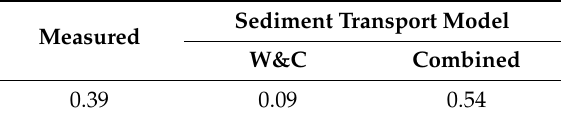
Table 3. The V Sh / V tot values, where V Sh is the volume of the shifted and V tot is the total volume of the total deposition